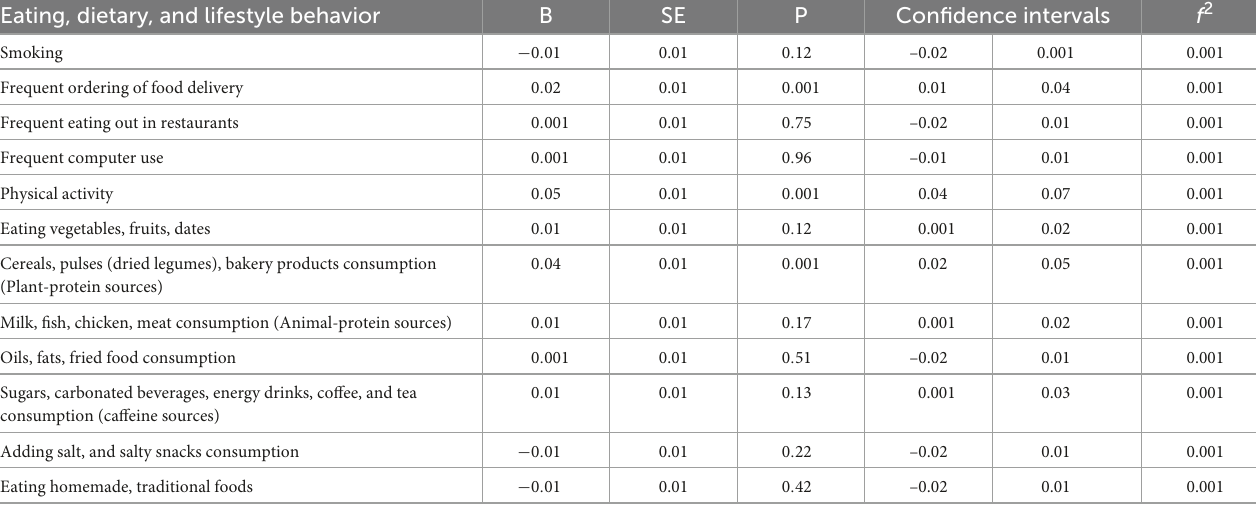
TABLE 5 Associations between dietary and lifestyle behavior modification and self-evaluated sleep quality ( N = 24,541). Eating, dietary, and lifestyle